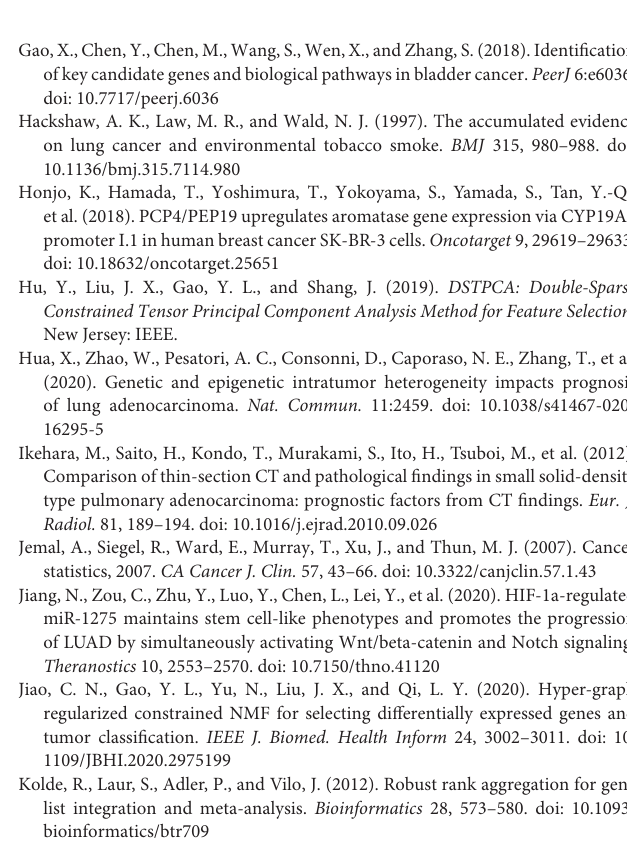
Supplementary Table 3 | Clinical information of patients in GSE72094 dataset. Supplementary Table 4 | Results of univariate Cox regression analysis. Supplementary Table 5 | Results of LASSO regression